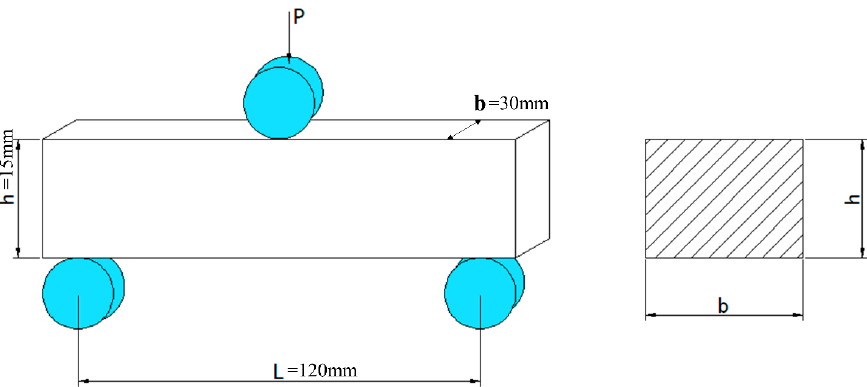
Figure 1. Sample size and experimental mounting diagram.